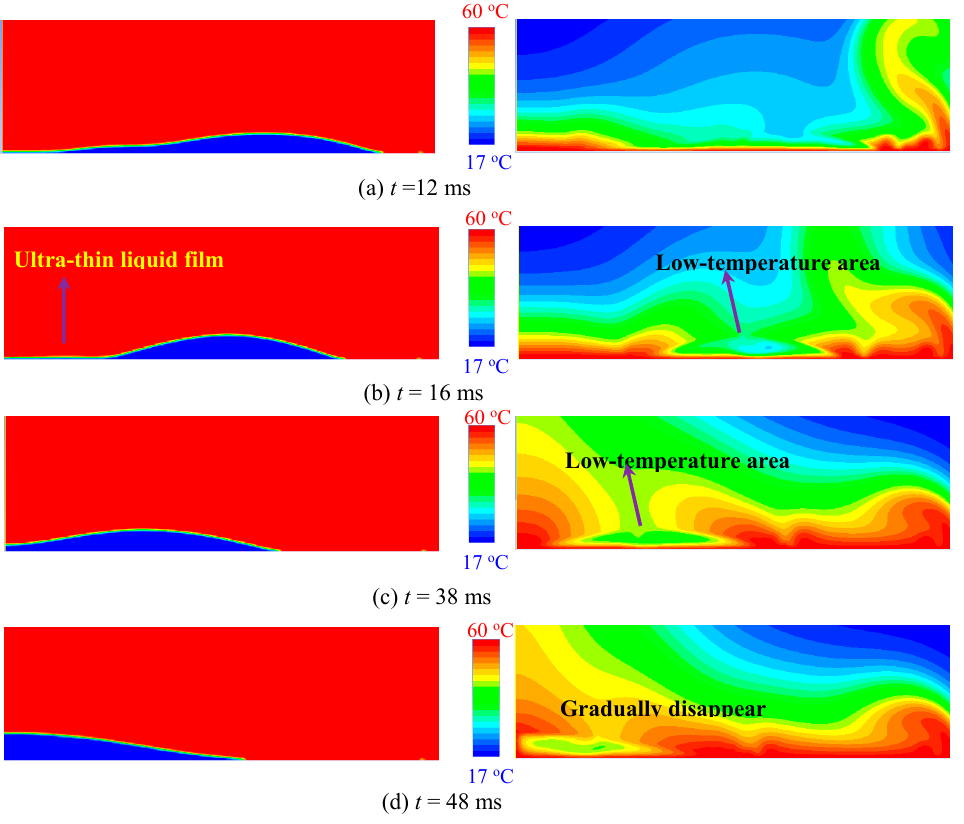
Figure 12. Phase and temperature distribution of the liquid film on superhydrophilic surface for W e = 16, T w = 60 ◦ C ( a ) t = 12 ms, ( b ) t = 16 ms, ( c ) t = 38 ms, ( d ) t = 48 ms. The bottom left corner is the droplet impact